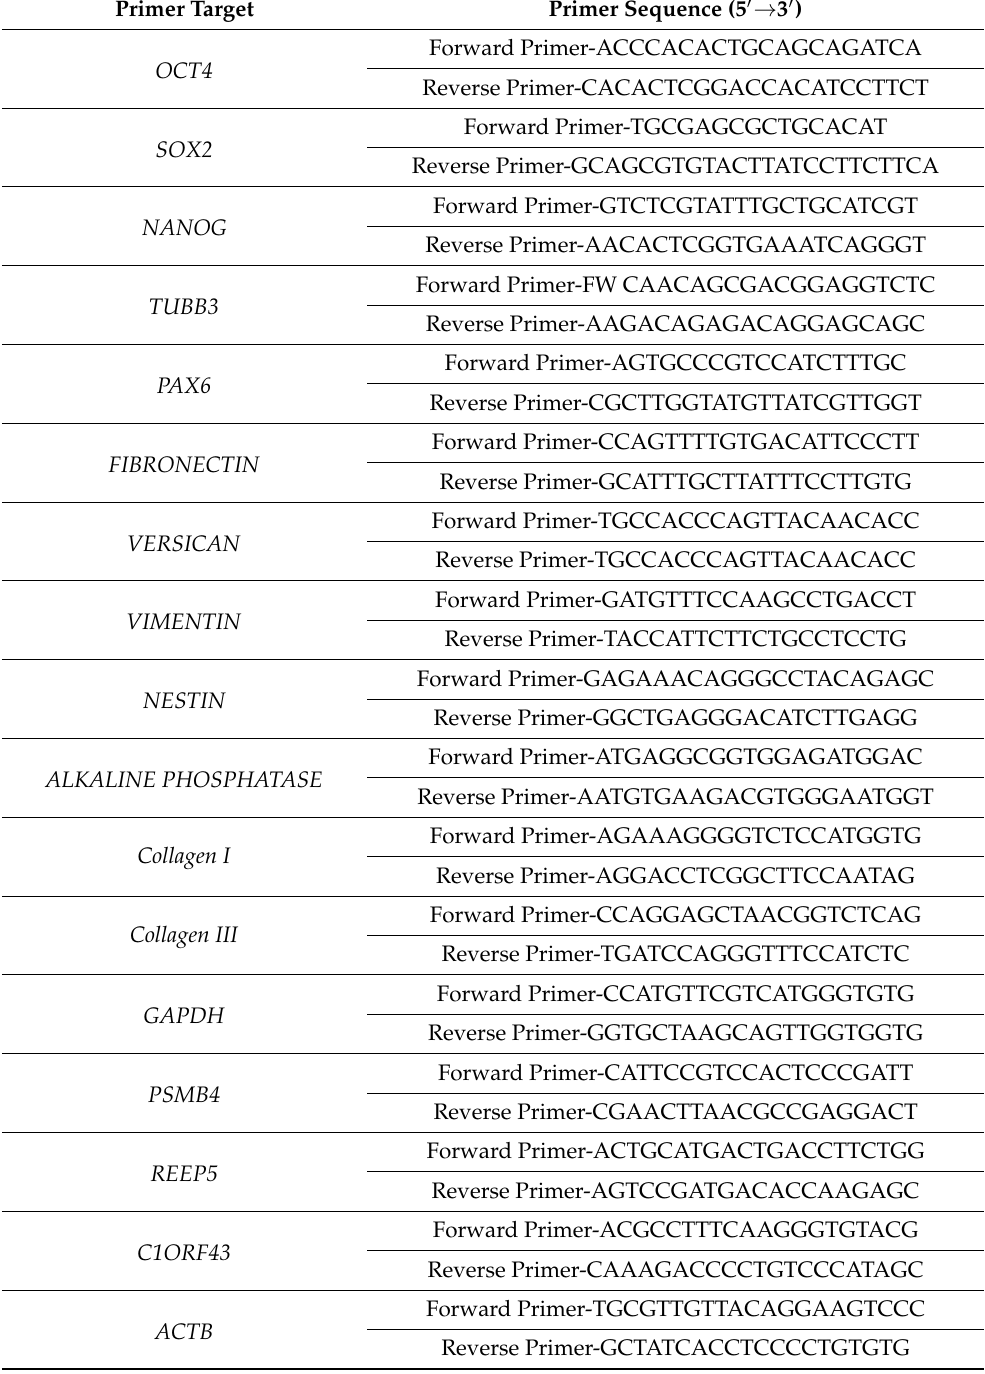
Table 1. The primer sequences for RT-PCR analysis of the expression of specialized